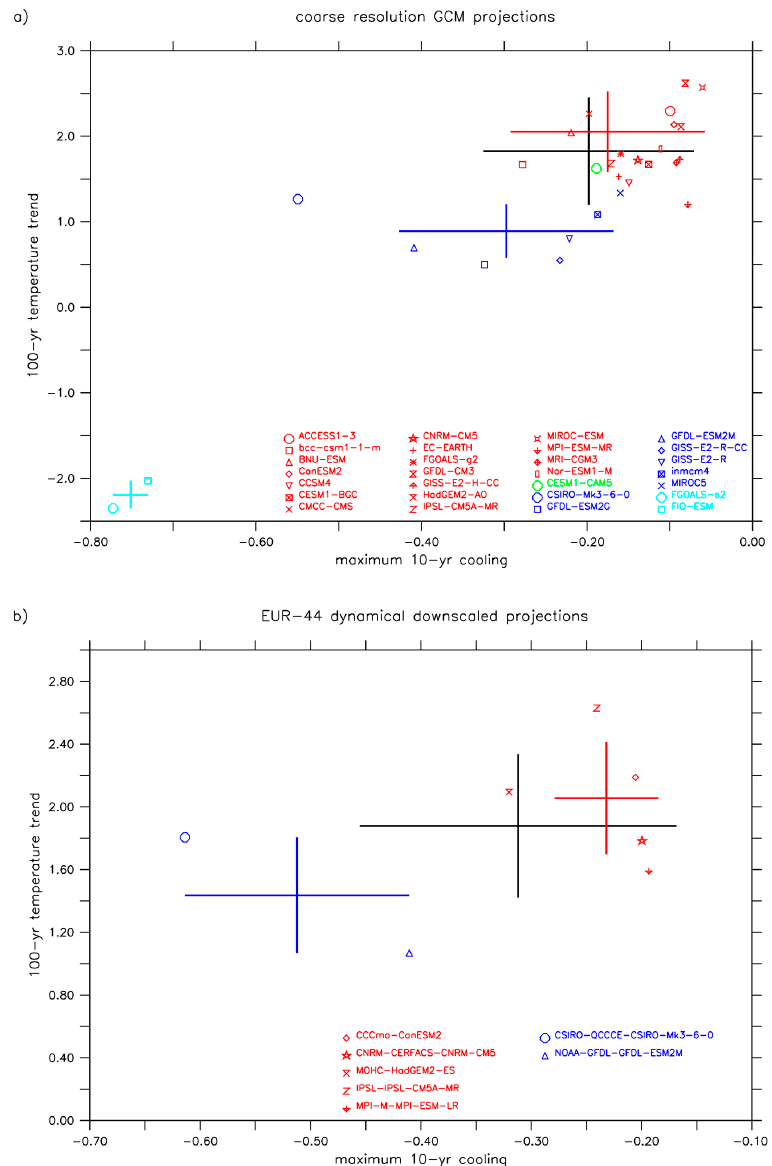
Figure 1. Scatterplot of the simulated 100-year temperature trend (in ◦ C) versus the maximum 10-year cooling event (in ◦ C) over western Europe for ( a ) the 37 coarse-resolution fifth coupled model intercomparison project (CMIP5) projections and ( b ) the 7 dynamical downscaled projections for the representative concentration pathways (RCP)4.5 scenario. Di ff erent colors follow the model clustering proposed in Sgubin et al., 2017, which groups projections not showing any abrupt change in the subpolar gyre (SPG) (red), projections producing a SPG convection collapse (blue), and projections simulating an Atlantic meridional overturning circulation (AMOC) collapse within 2100 (cyan). The green point in the upper panel corresponds to CESM1-CAM5, which is a model showing a SPG convection collapse, but only for RCP8.5. Crossing lines individuate the mean and the standard deviation of each subset of models, with the black lines corresponding to the ensemble of all the models. For multiple models developed at the same institute, we displayed just one point for a matter of readability in the diagram, e.g., among the di ff erent models developed by the Institut Pierre Simon Laplace (IPSL), we just displayed results of IPSL-CM5A-MR. However, all the projections have been considered in the calculation of the di ff erent clusters’ ensemble mean and